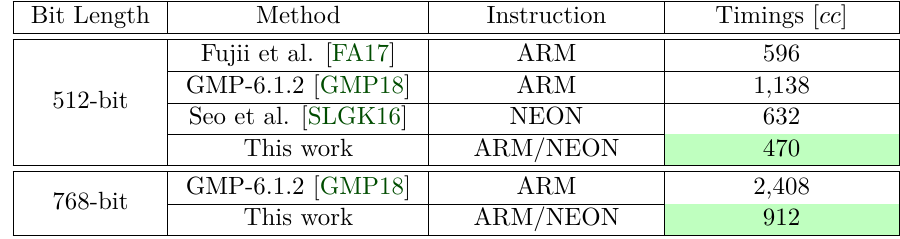
Table 2: Comparison of implementations of 512-bit and 768-bit multiprecision multiplication on an ARM Cortex-A15 processor (32-bit ARMv7-A architecture). Timings are reported in clock